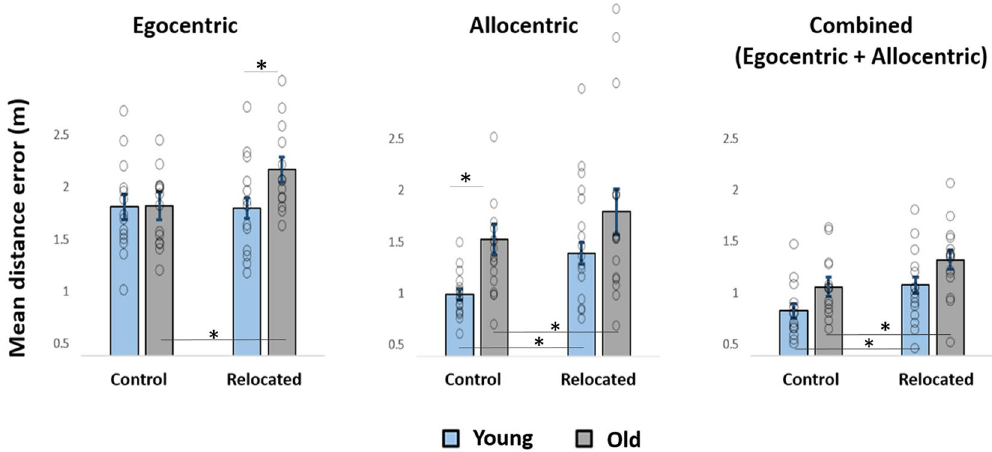
Figure 3. Age and spatial cues influence spatial memory and spatial updating. Distance errors to the latest locations of relocated and non-relocated (control) objects, in the egocentric (left) allocentric (middle) and combined (right) conditions, are shown. Shorter distance errors indicate higher retrieval accuracies. The control objects represent spatial memory while the difference between distance errors of relocated and control objects represent the spatial updating deficit. The ANCOVA revealed an age-related deficit in spatial updating in the egocentric condition. Data are presented as mean ± SEM. * p < 0.05 in post-hoc